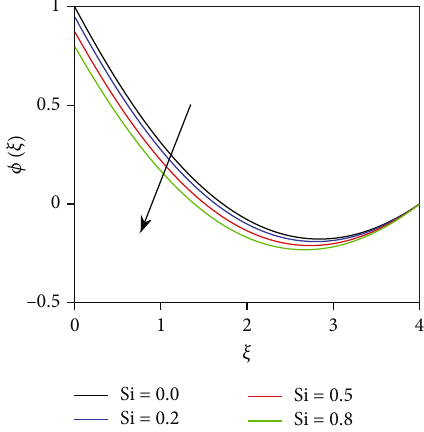
Figure 16: Concentration pro fi les for solutal jump parameter Si